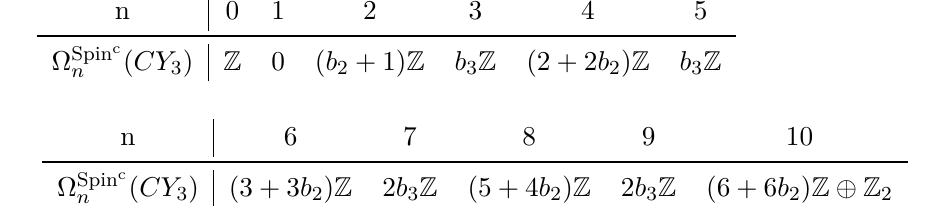
Table 14 . Cobordism groups Ω Spin c